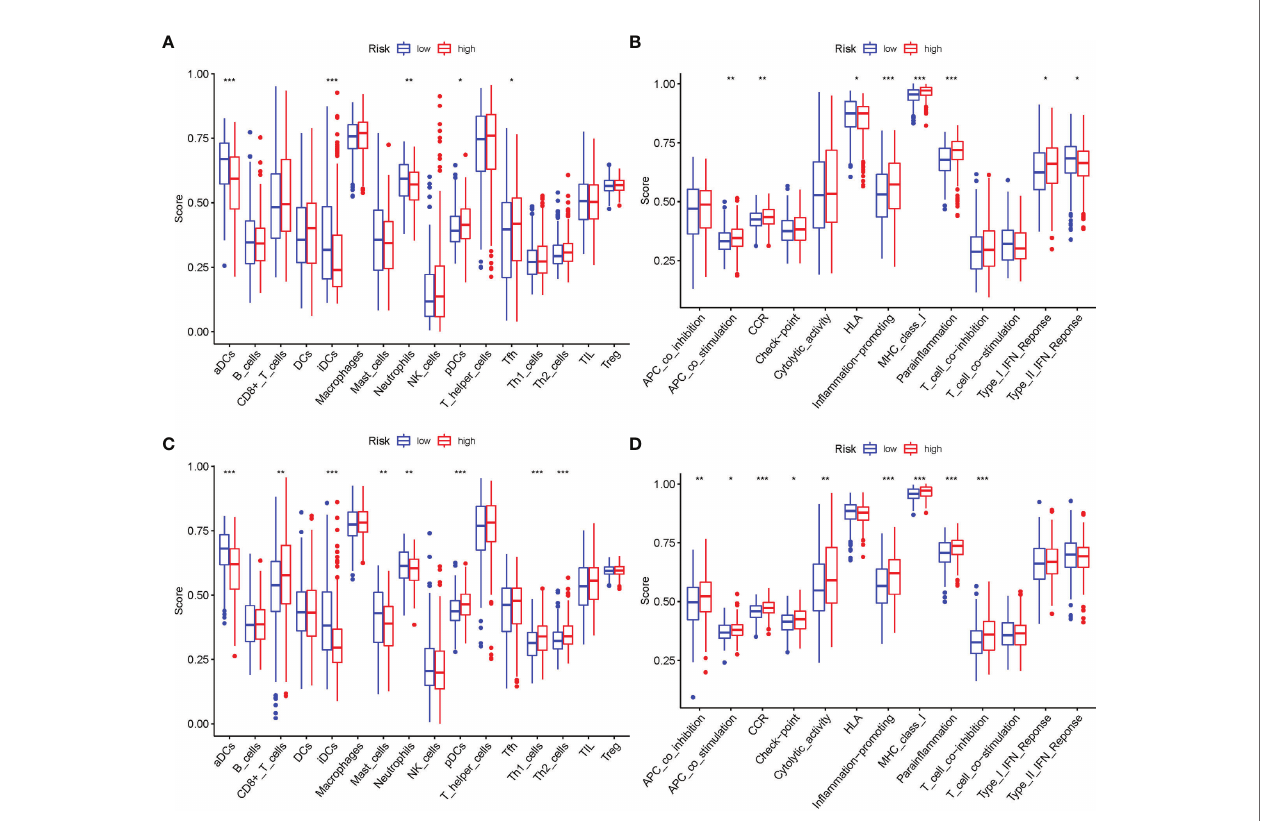
FIGURE 10 | Comparison of the ssGSEA scores. (A, B) Comparison of the enrichment scores of 16 types of immune cells and 13 immune-related pathways between low-risk (green box) and high-risk (red box) group in TCGA cohort. (C, D) Comparison of the tumor immunity between low-risk (blue box) and high-risk (red box) group in the GEO cohort. *P < 0.05; **P < 0.01; ***P <